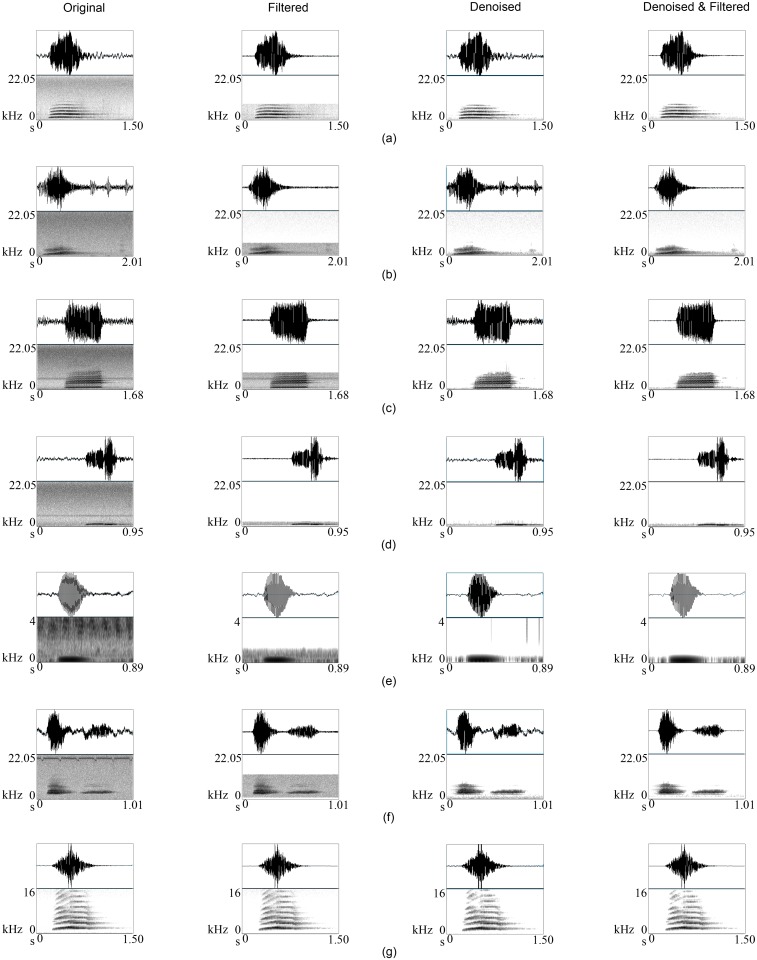
Bird call examples of before, after filtering, after denoising using wavelets as described in the text, and after denoising and classical filtering.(a) A whistle of a male North Island brown kiwi, (b) a call of female North Island brown kiwi, (c) a ruru trill, (d) a ruru more, (e) a kakapo booming, (f) a kakapo chinging, and (g) a less noisy example of male kiwi.